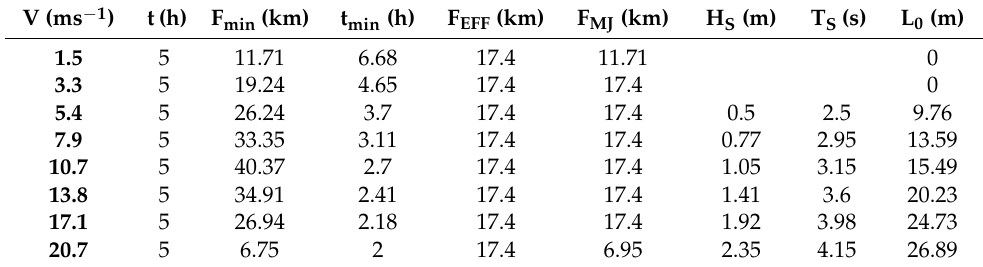
Table 5. Deepwater wave parameters—incident direction SSW.